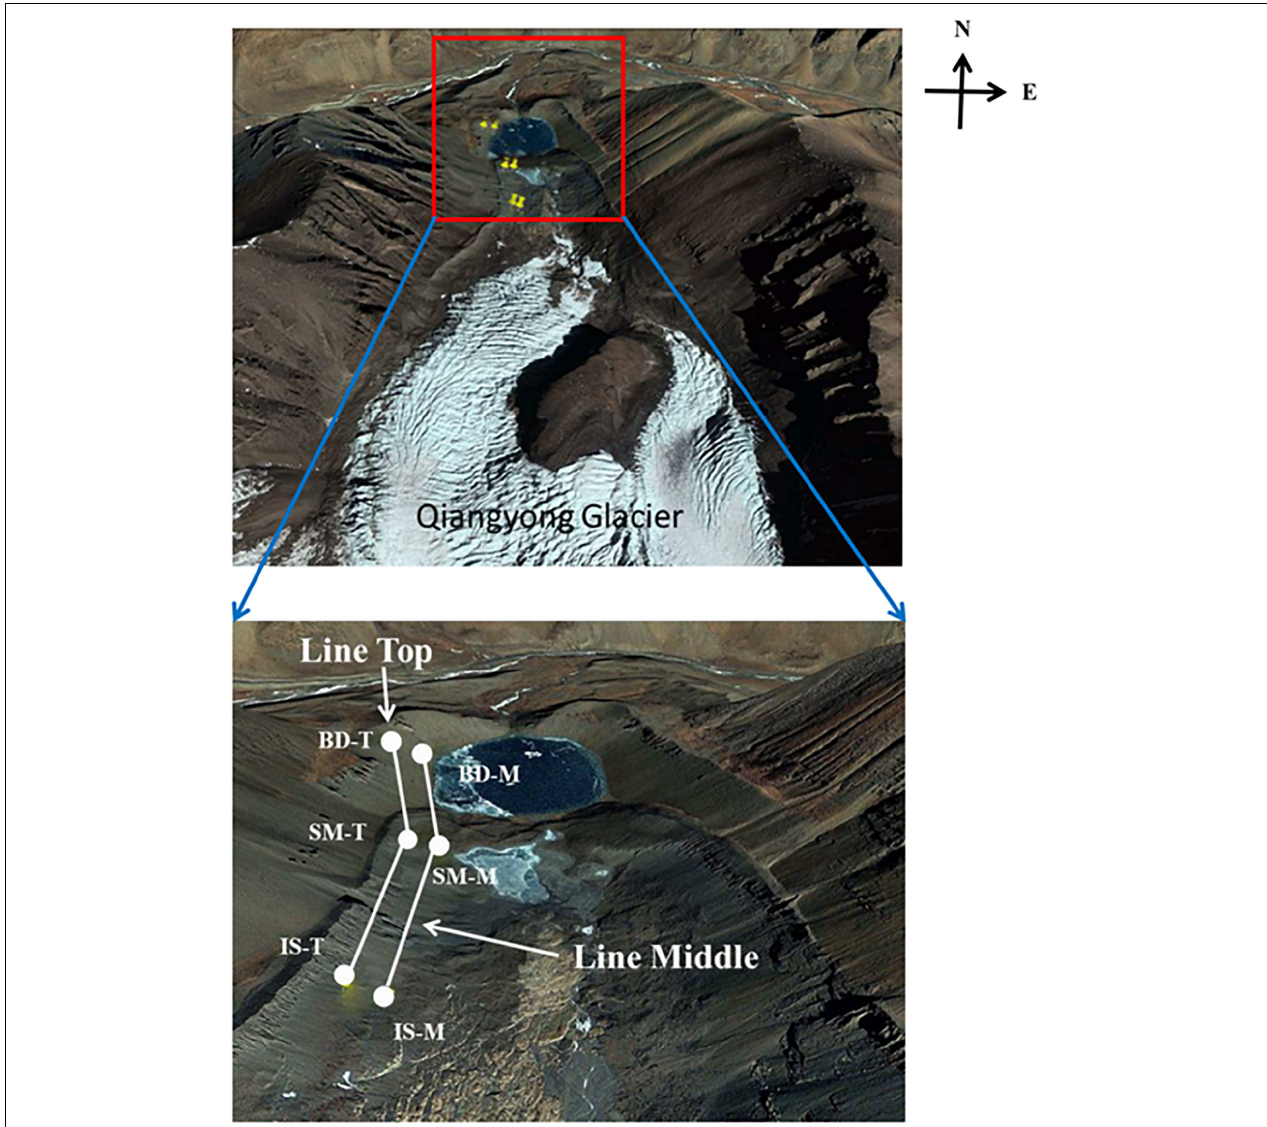
FIGURE 1 | Map of sampling locations along the Qiangyong Glacier retreat chronosequence. Sites: IS, middle of glacier terminal and small Qiangyong lake; SM, midway along the edge of the smaller lake; BD, approximately one-third of the way along the edge of the larger lake; M and T, the sampling lines, Middle and Top,